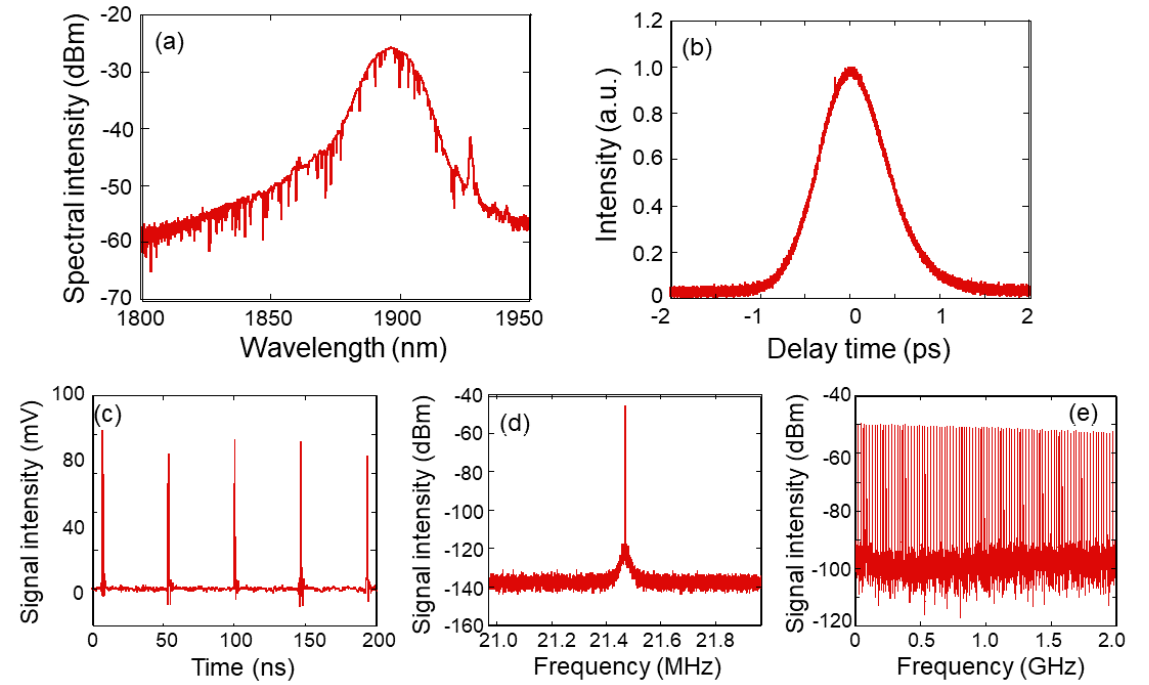
Figure 7. Characteristics of output pulses when D = +0.0153 ps 2 and spectral filter was not used, ( a ) optical spectra, ( b ) autocorrelation trace, ( c ) pulse train, ( d , e ) RF spectra of ( d ) fundamental frequency and ( e ) wide range.